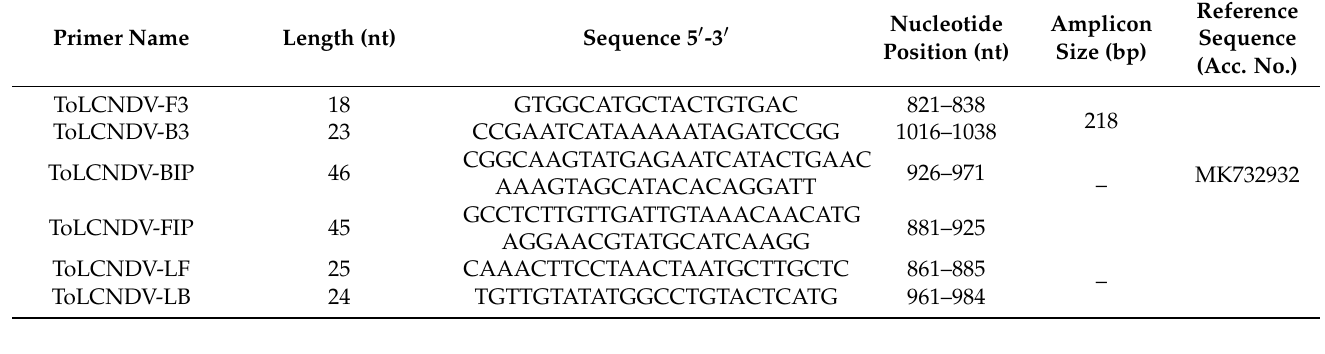
Table 2. LAMP primers for ToLCNDV detection designed in this study.